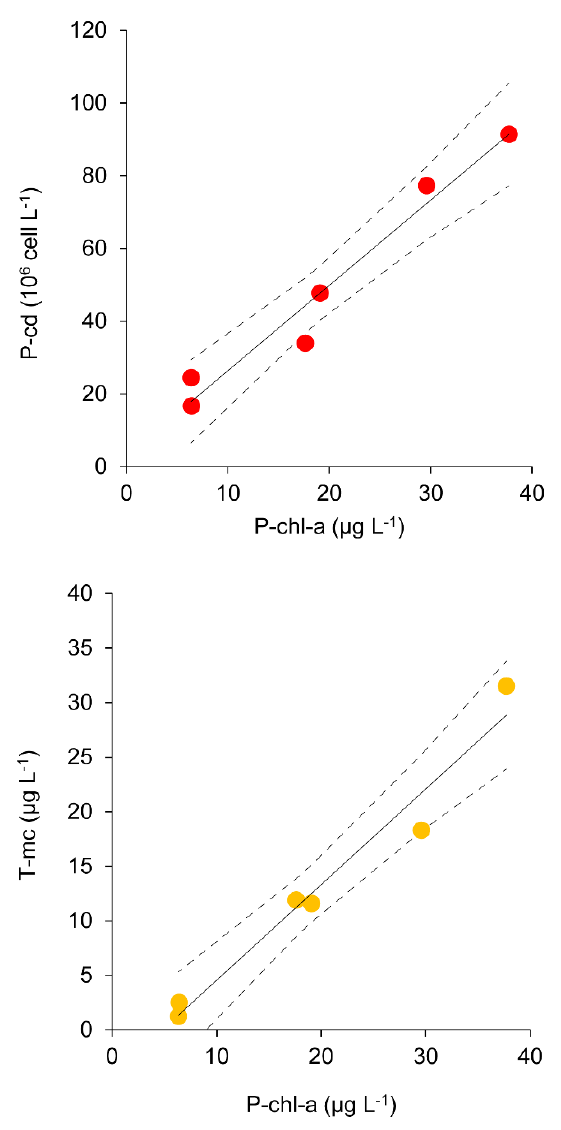
Figure 4. Upper panel linear regression (solid line) between P. rubescens chlorophyll-a content (P-chl-a) and P. rubescens cell density (P-cd). Dashed lines, 95% confidence interval P-cd: 6.5–105 × 10 6 cell L − 1 . Lower panel, linear regression (solid line) between P-chl-a and total microcystin (T-mc). Dashed lines, 95% confidence interval 0-34 µg L − 1 . Data refer to the P-chl-a peak in stations St2, St6, and St11 at a depth of 2, 2.5 and 7 m on 6 April 2009 and 2.5, 10, and 10 m on 26 June 2009.